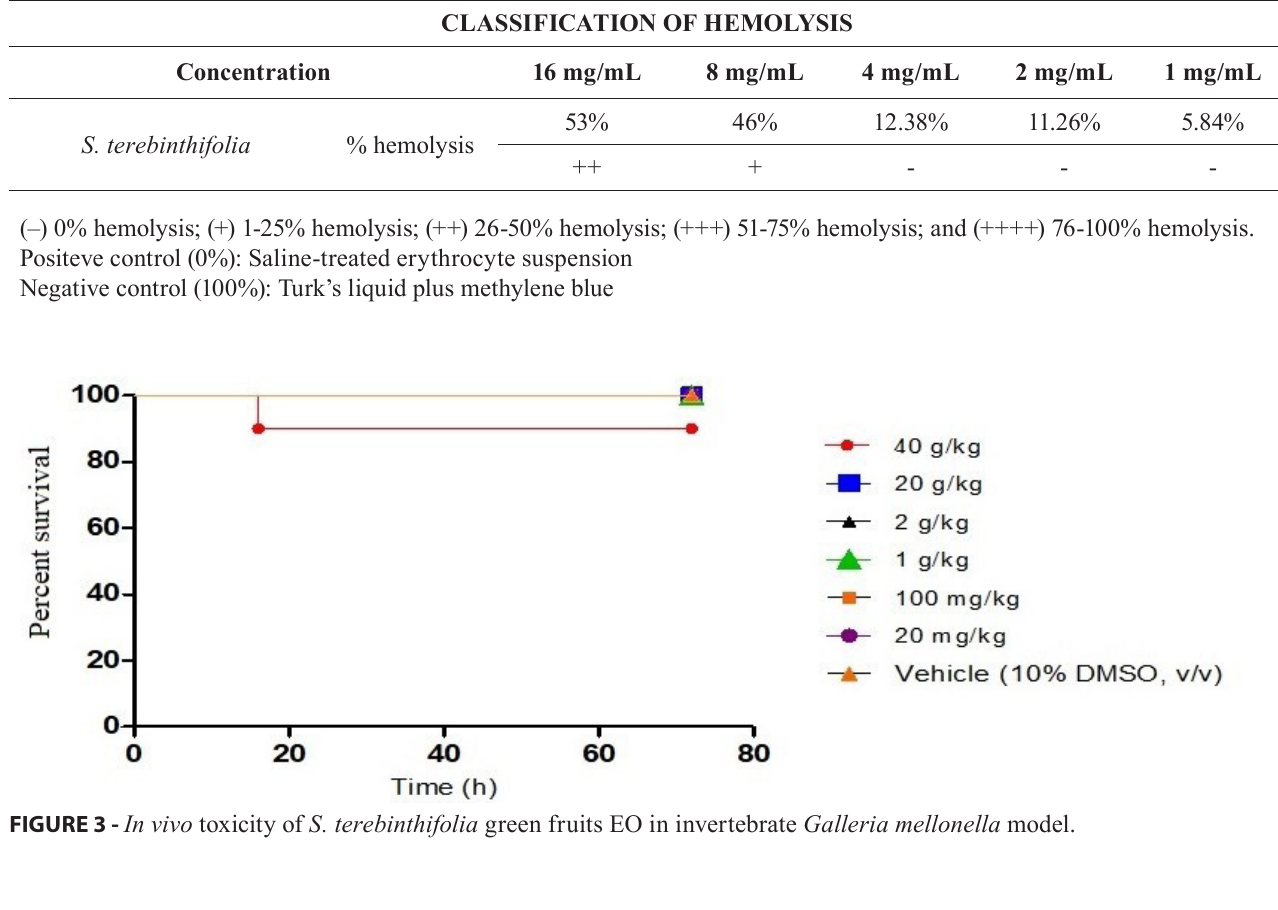
TABLE IV - Percentage distribution of the hemolysis produced by the S. terebinthifolia green fruits EO, according to the